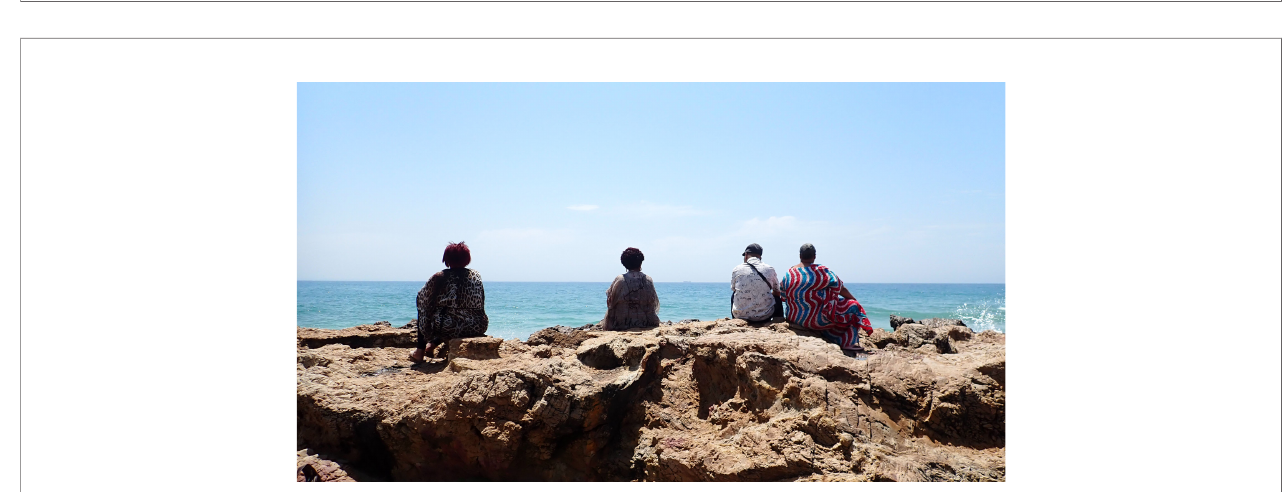
FIGURE 6 | Photograph by Anelisa Mcoli. People often come to the ocean to connect with their ancestors and seek guidance.